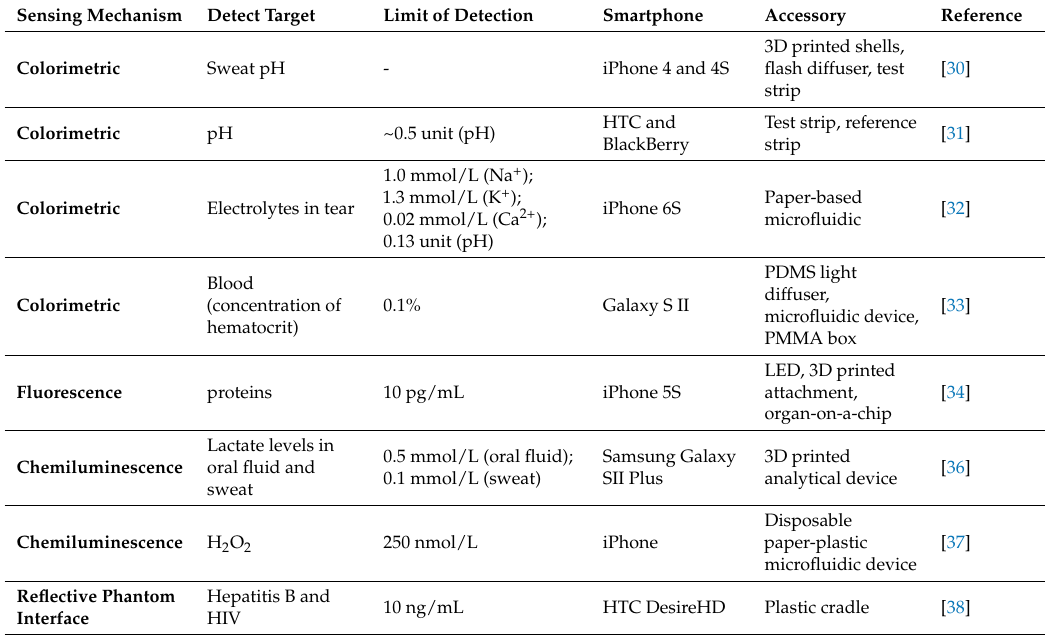
Table 2. Biosensor based on colorimetric on smartphone